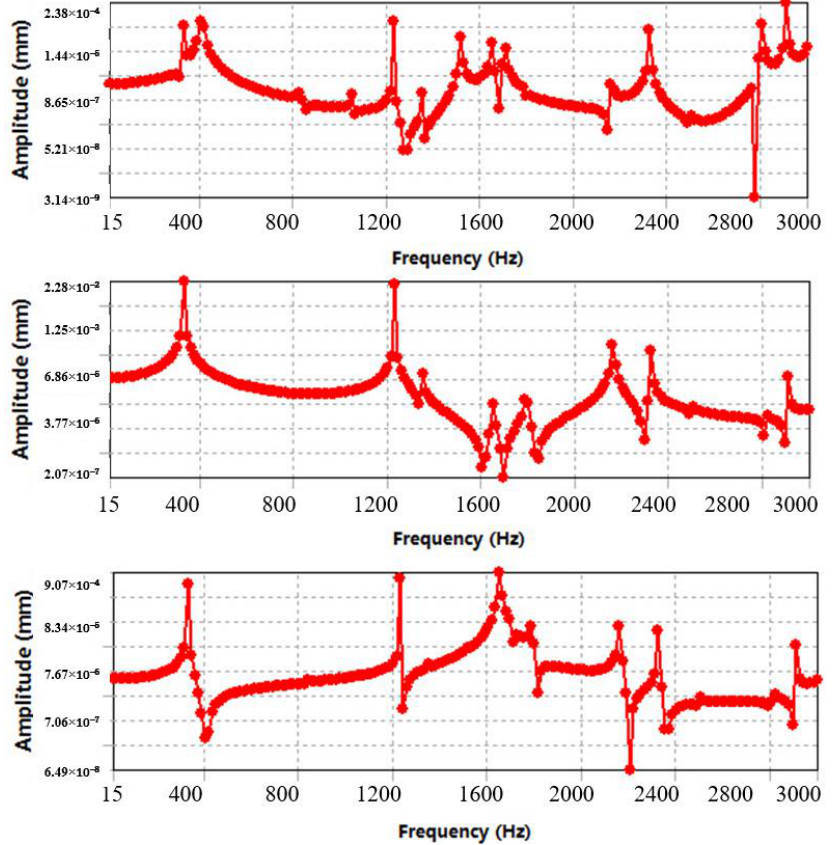
Figure 14. Harmonic response in X/Y/Z direction at the lower limit of integral structure.